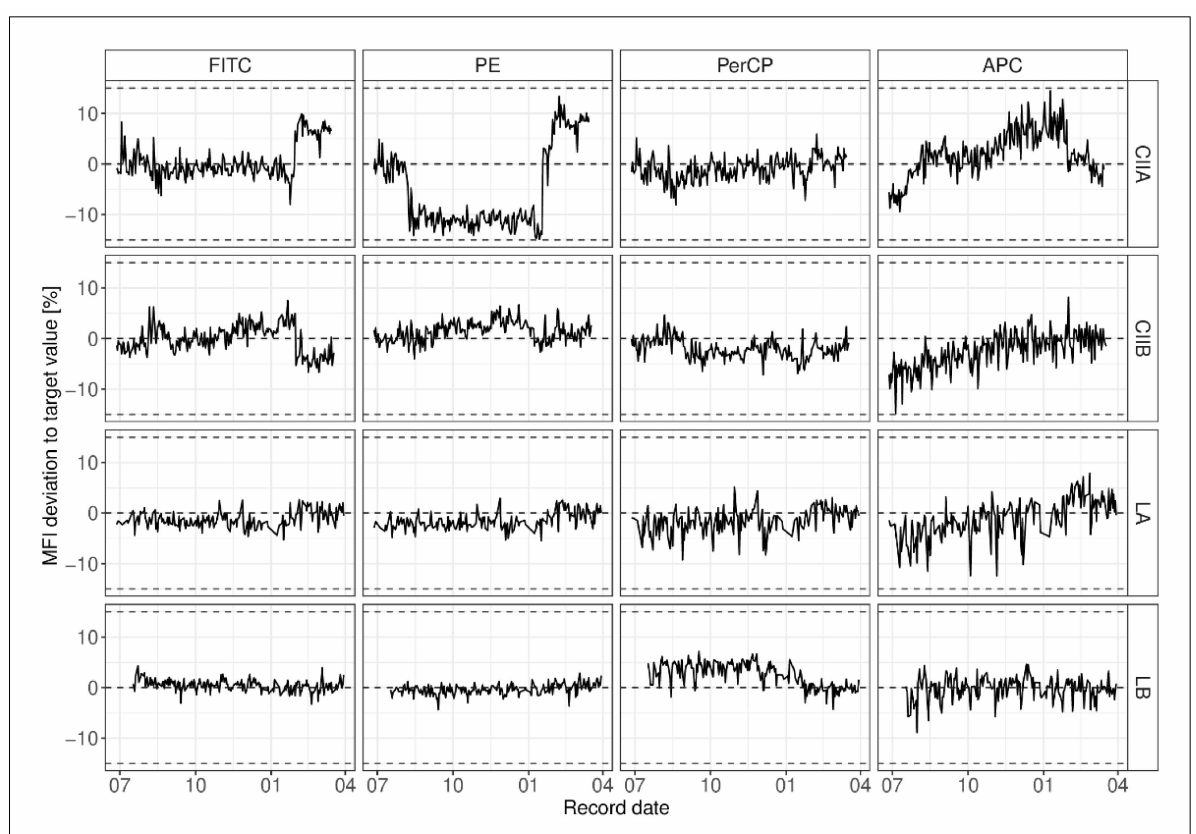
Figure 2. Variability of daily quality control measurements of peak-7 Rainbow beads’ MFI differences to the target values on different flow cytometry instruments (CIIA, CIIB: CantoII; LA, LB: Lyric) under equal environmental conditions during a time period of 8